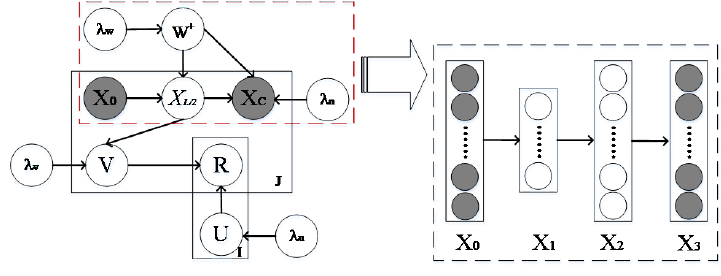
Fig. 1 Collaborative deep learning